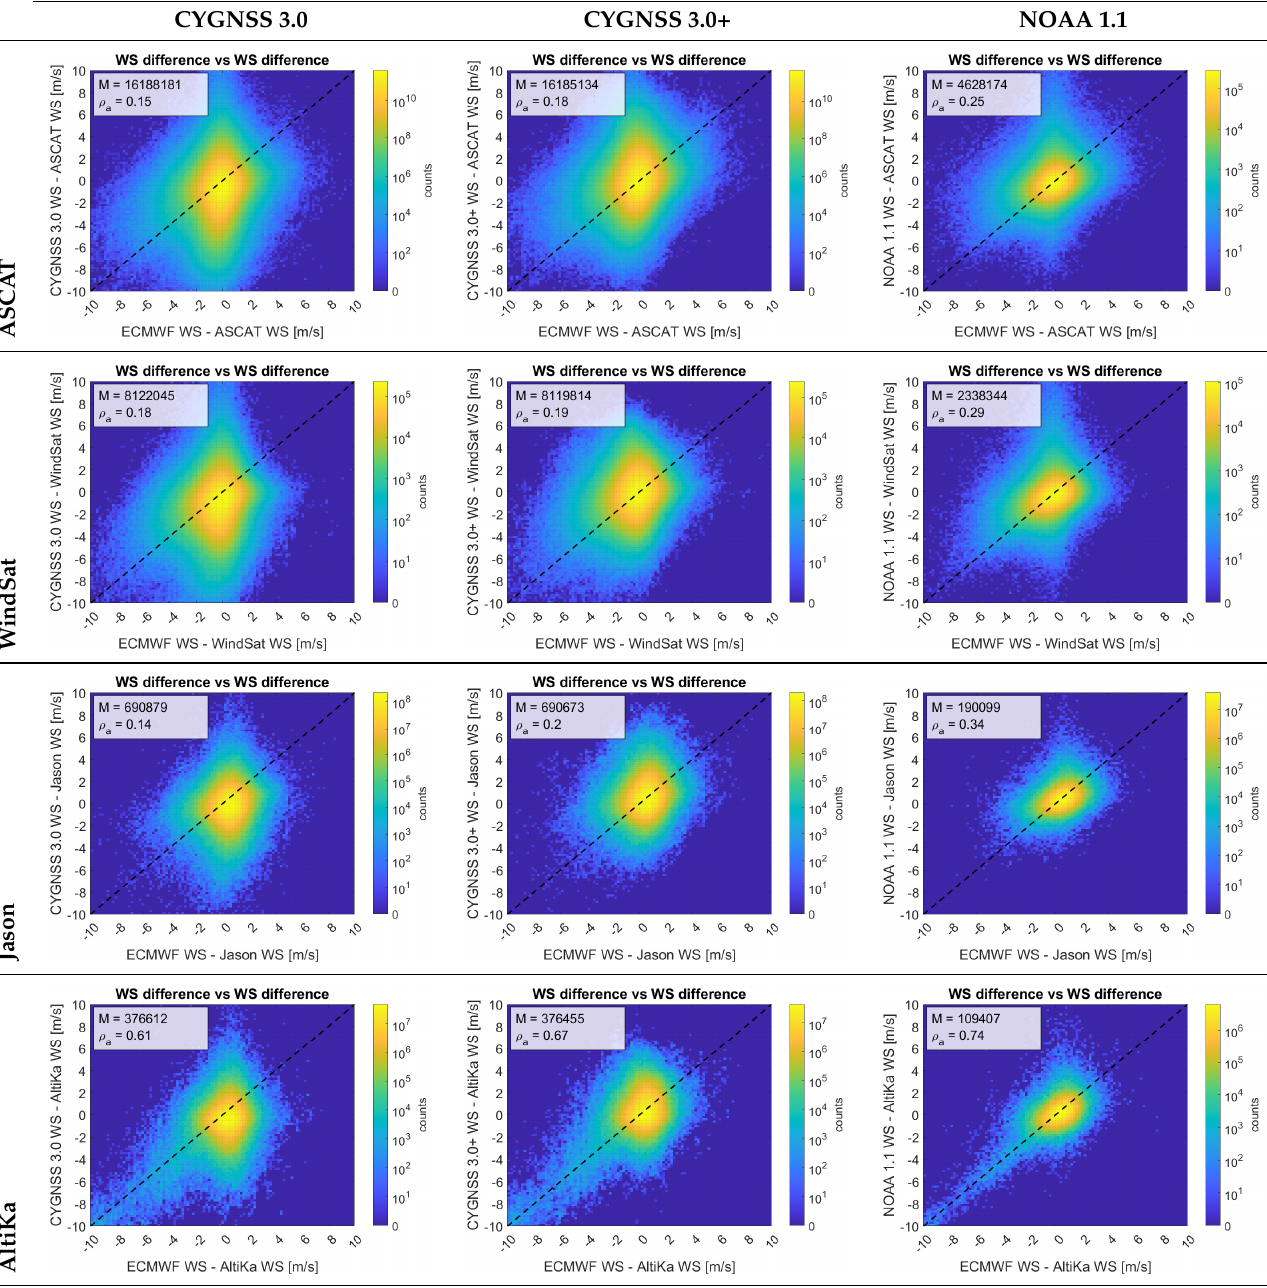
Figure 10. Histograms of the difference between different CYGNSS wind estimates (columns) and the wind speed from different sensors (rows) vs the difference between the same sensors winds and the ECMWF wind speeds. The inner boxes show the metrics given in Table